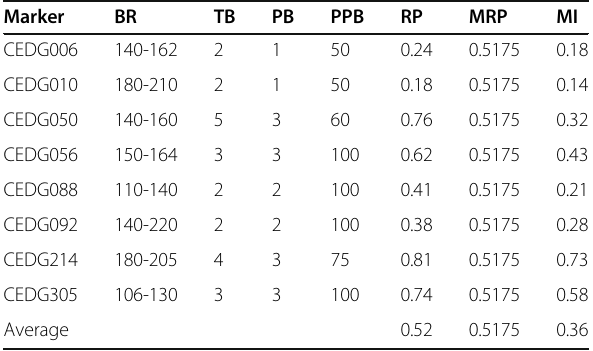
Table 4 SSR markers used on the mung bean genotypes Marker